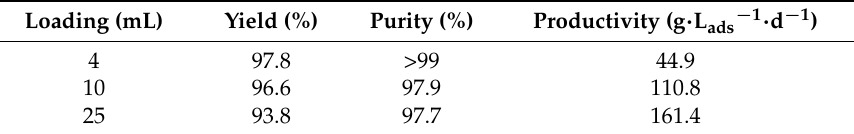
Table 5. Process parameter for different column loadings and